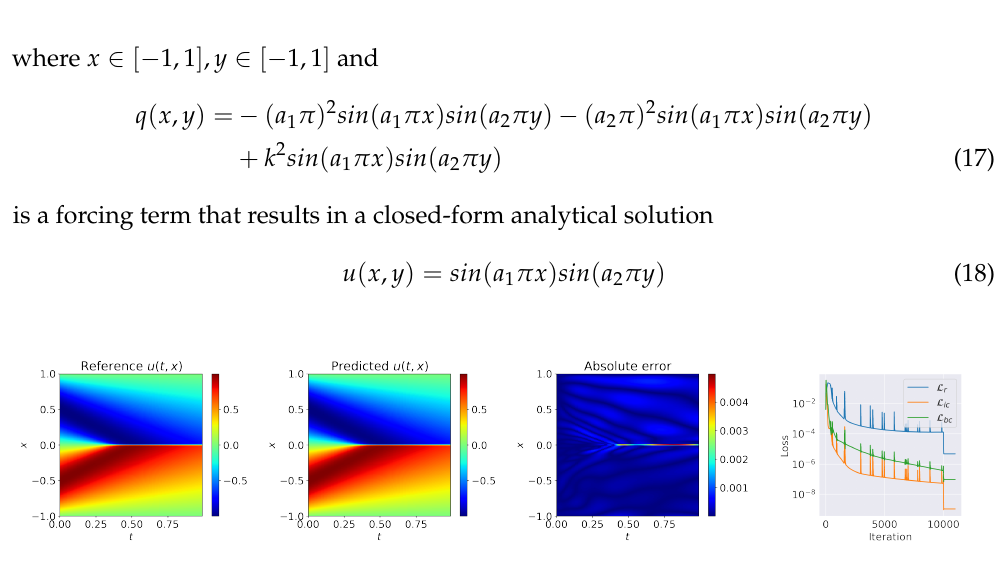
Figure 5. cSPINNs results (with ResNet block-enhanced modified neural network) for solving 1D viscous Burgers